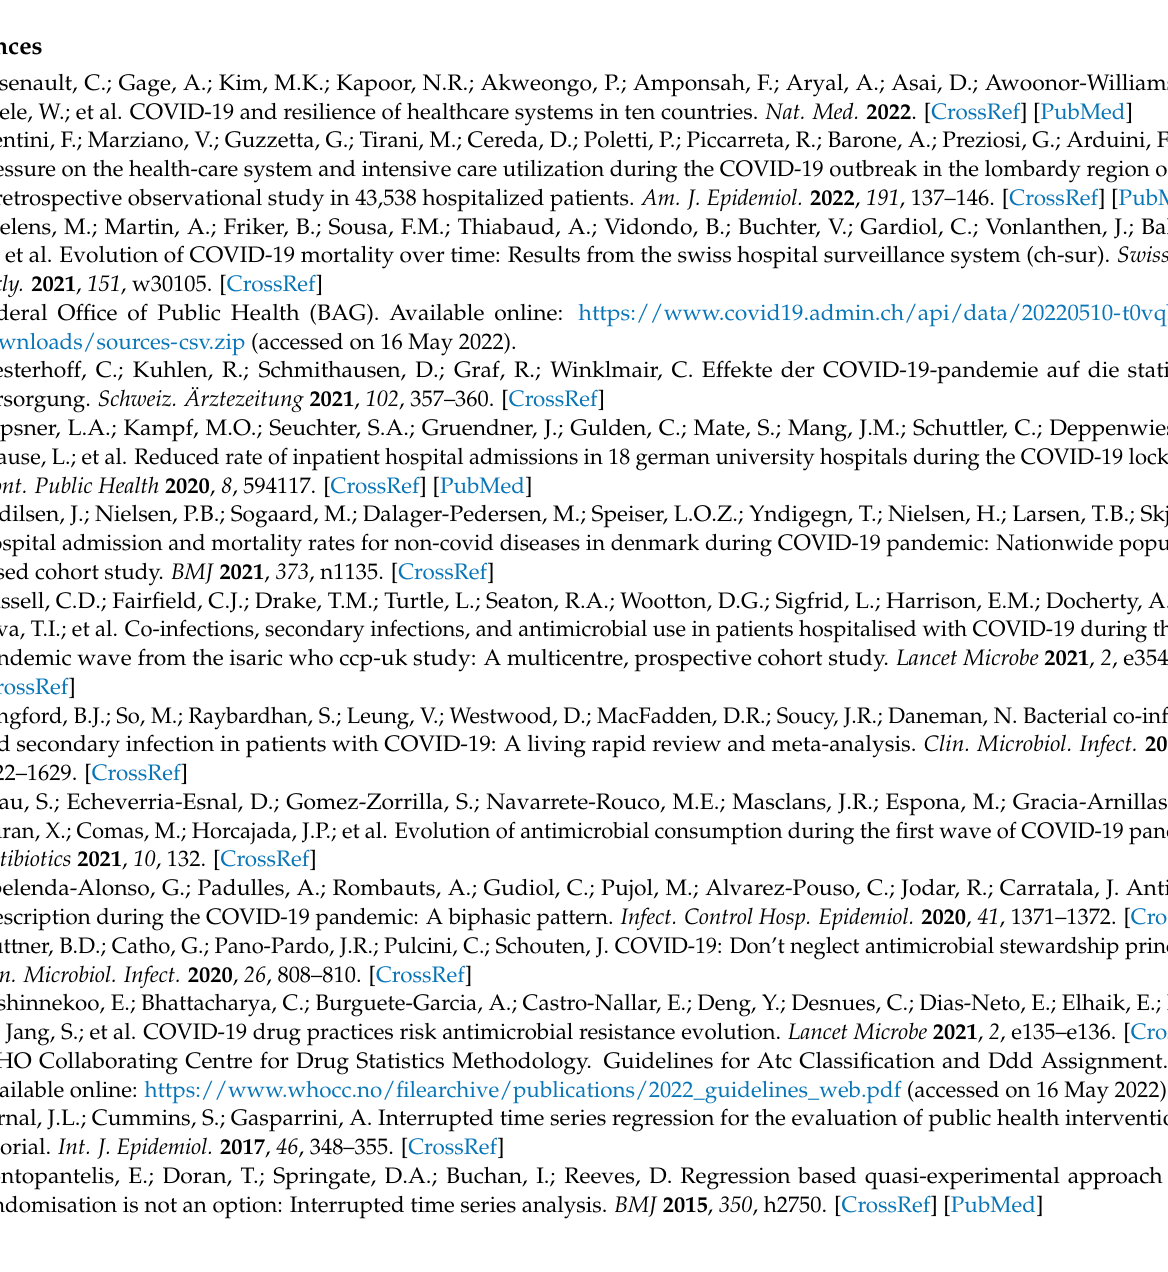
monthly IQVIA data; Figure S1: Characteristics of the four hospitals submitting monthly antibiotic consumption data; Figure S2: Monthly antibiotic sales data in DID in the different linguistic regions; Figure S3: Map showing the locations of the hospitals included in the ANRESIS